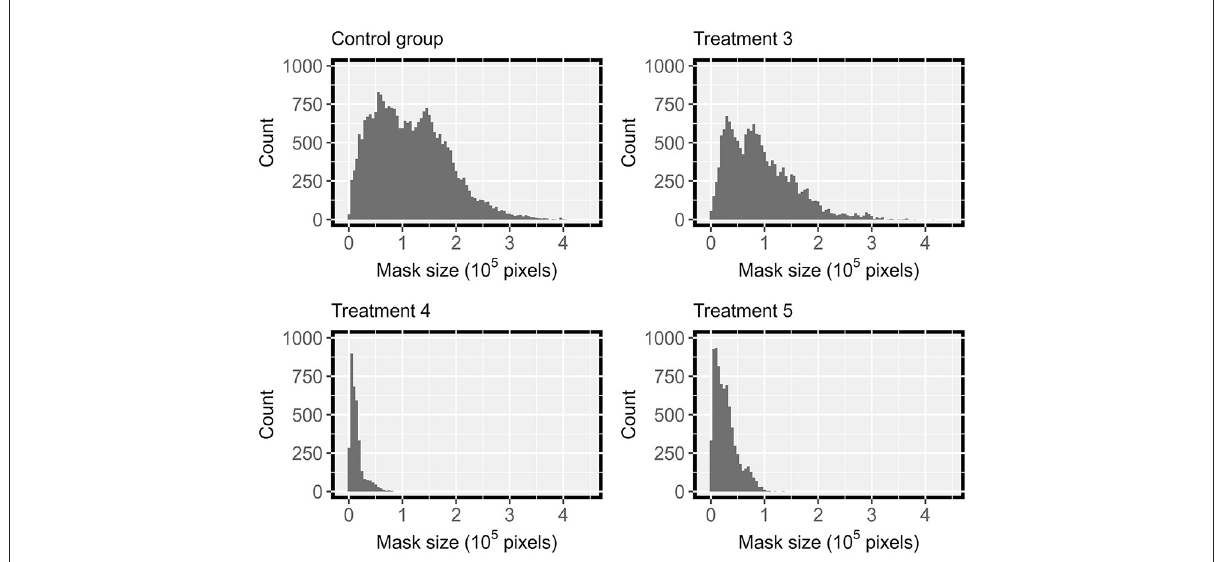
FIGURE5 Distribution of manually labeled ground truth mask size in DM testing datasets from treatment 3,4,5 and the control group, with severity rating of of “b”, “bc”, “c”, “a”, in Table 2